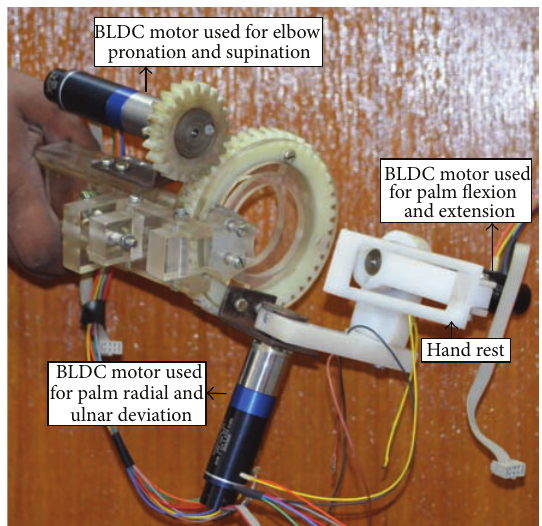
Figure 10: Manufactured model of wrist